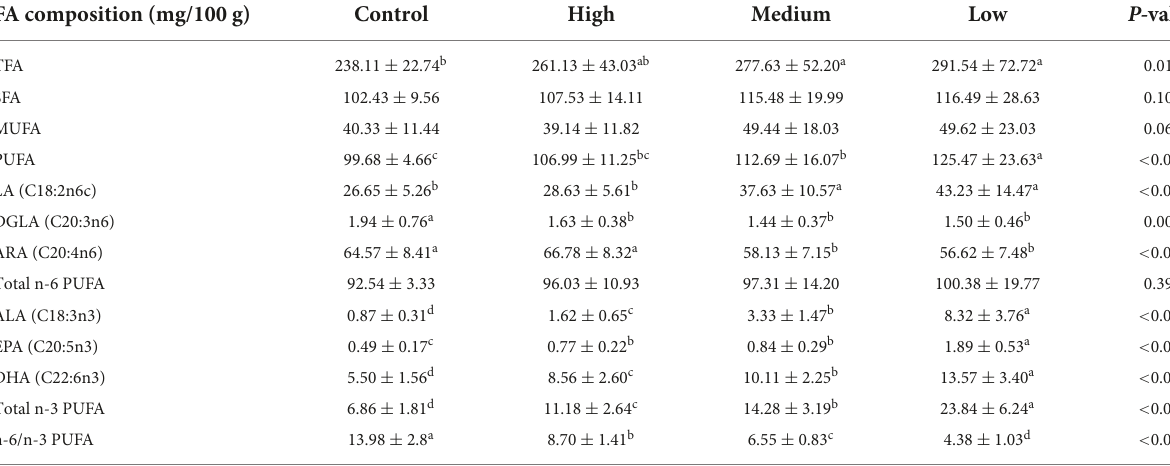
TABLE 5 Effects of different linseed oil levels on the polyunsaturated fatty acid (PUFA) profile of duck liver. FA composition (mg/100